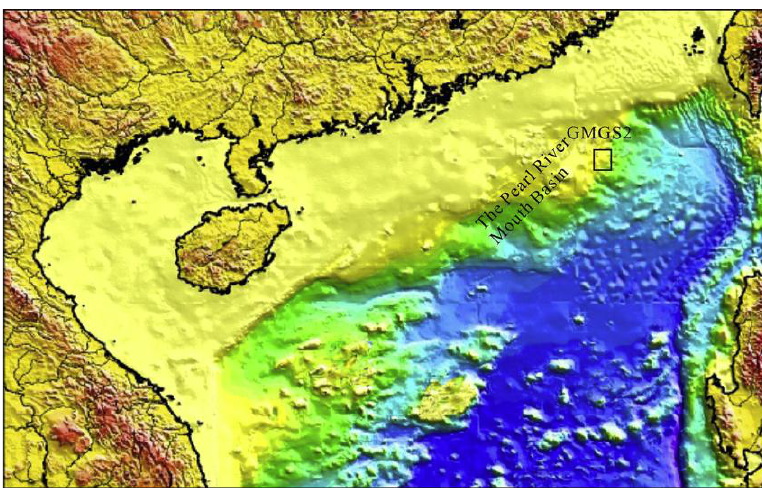
Figure 1. Map of northeastern part of South China Sea. The rectangle shows the location of the drilling area.